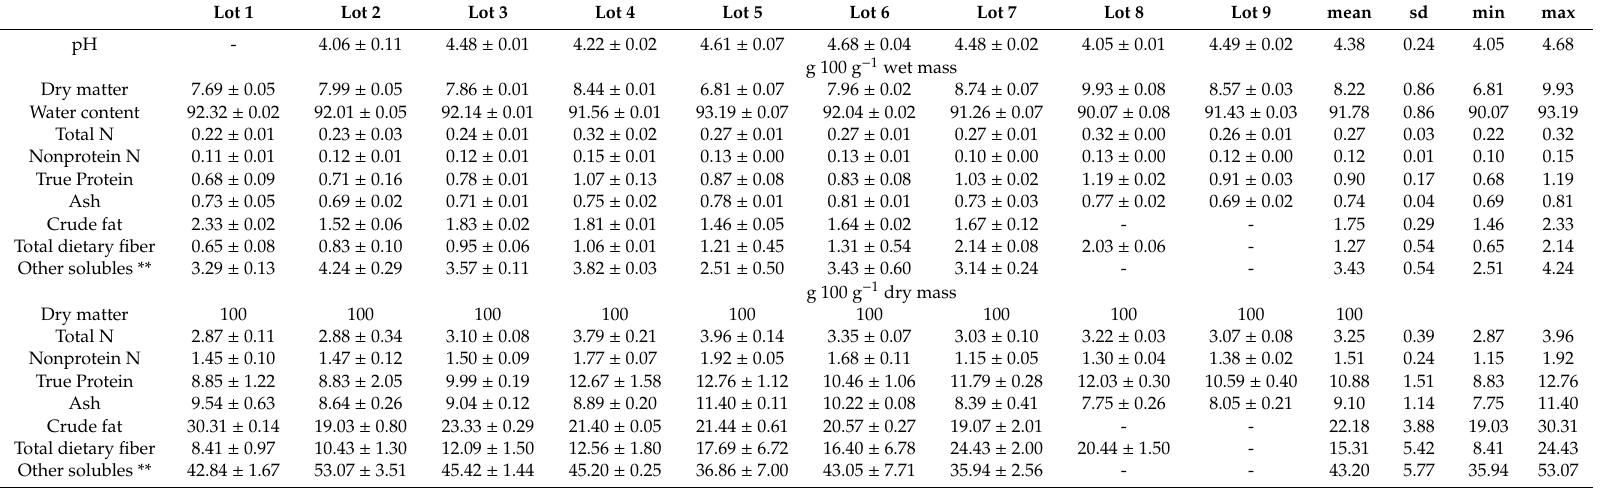
Table 3. Chemical composition of thin stillage derived from the dry-grind corn ethanol plant. Mean, standard deviation, and range of values observed over a one-year period (n = 9)